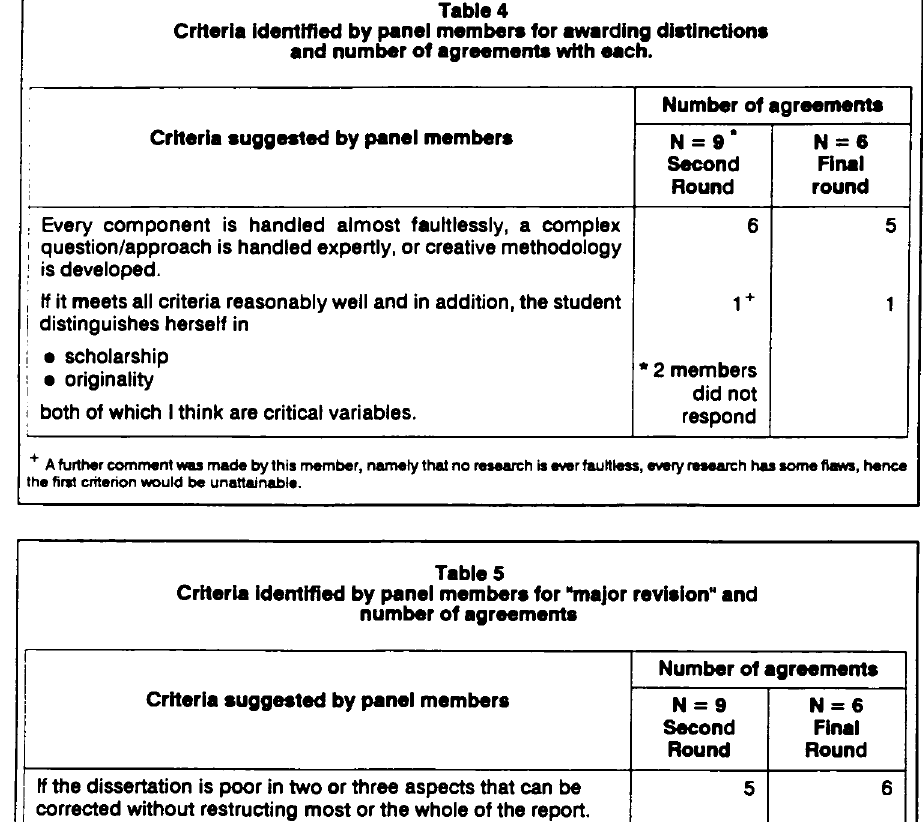
Criteria suggested by panel members